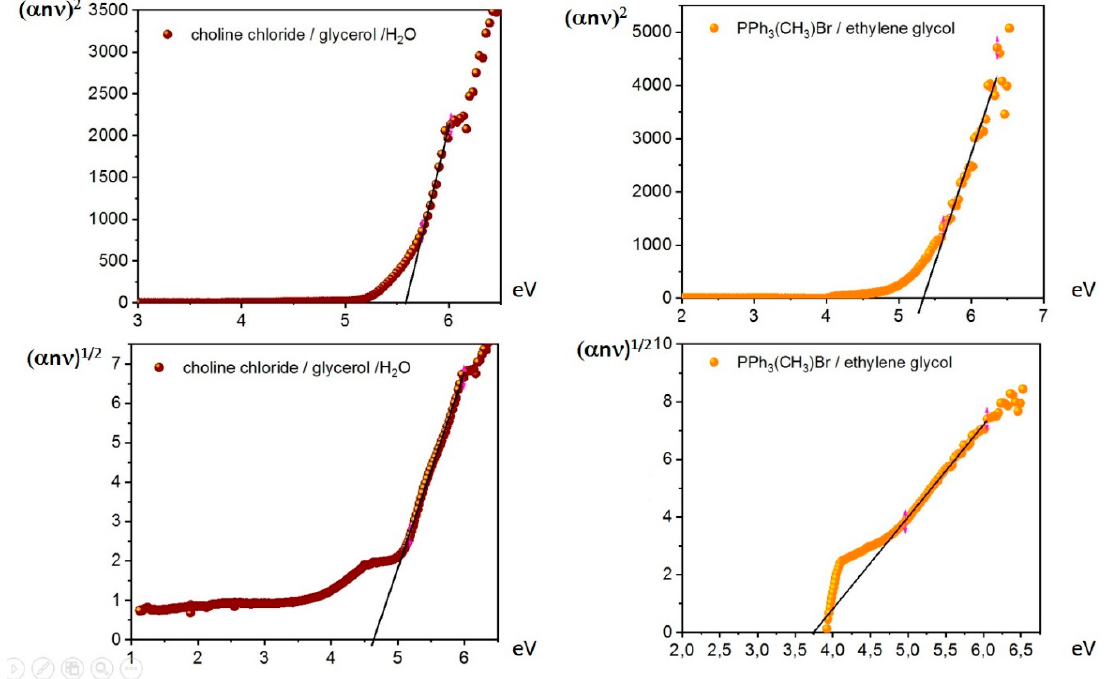
Figure 5. Tauc plots for (top) direct and (bottom) indirect transition of systems (left) 4 and (right) 5.